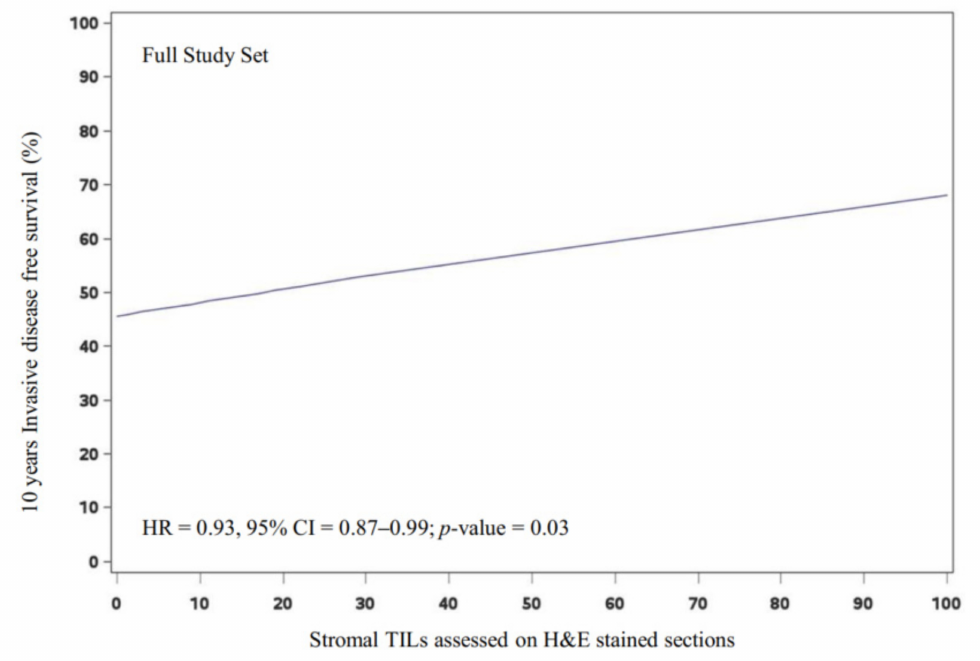
Figure 3. Prognostic significance of H&E sTIL in the full study set. Invasive disease-free survival plot and unadjusted hazard ratio for a 10-point difference in continuous H&E sTIL score (expressed as percentage) for the full study set ( n = 681), using 10-year IDFS as the end point. HR: hazard ratio, CI: confidence interval, H&E: hematoxylin and eosin, IDFS: invasive disease-free survival, sTIL: stromal tumor-infiltrating